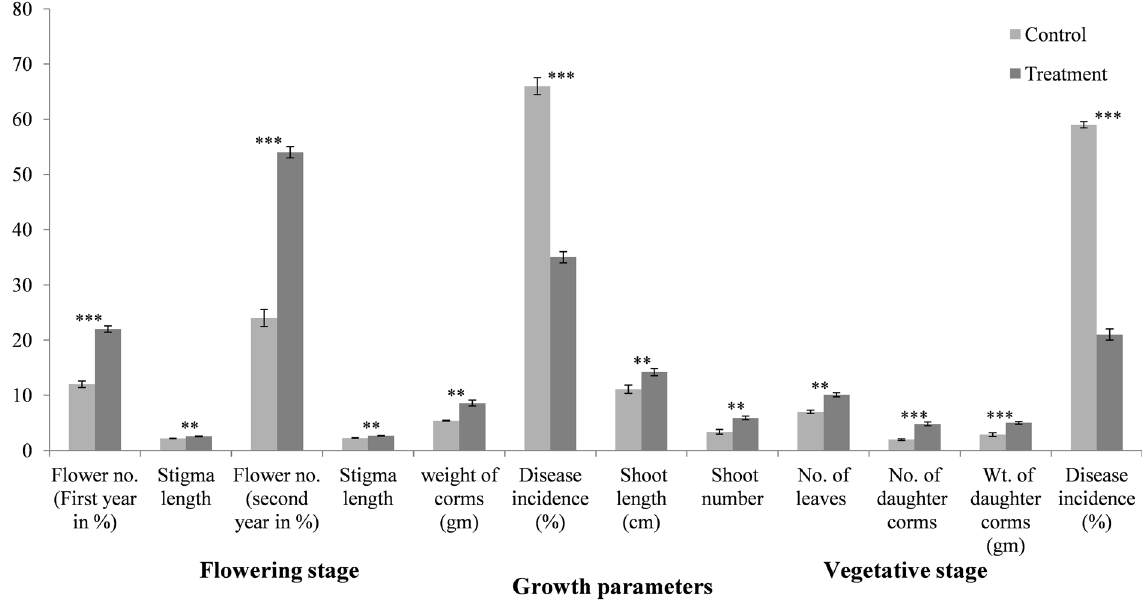
Figure 8. Evaluation of Bar D5 based bio - formulation on saffron growth during flowering and vegetatitive phase of life cycle in Jammu fields (Non traditional area of saffron cultivation). Results are the average of five replicates. Error bars represents the standard deviation. Corresponding results of ANOVA: *** represents the highly significant difference between means of control and treatment as P value (< 0.001), ** represents significant difference as P value (<